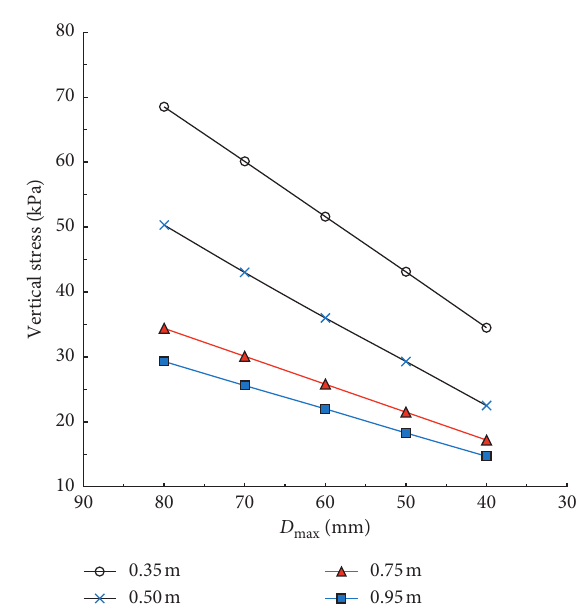
Figure 10: Maximum vertical stress in subgrade with different particle